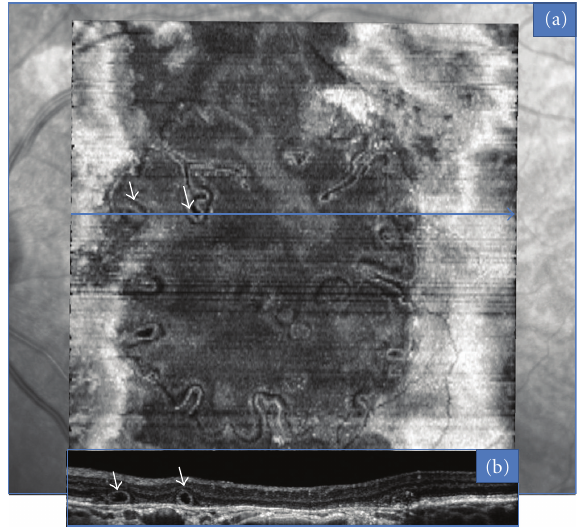
Figure 4: ORT observed with “en face” OCT in a case of geographic atrophy (a). ORTs follow a circular pattern associated with invagi- nations (arrows) inside the atrophic zone. Corresponding B-scan OCT